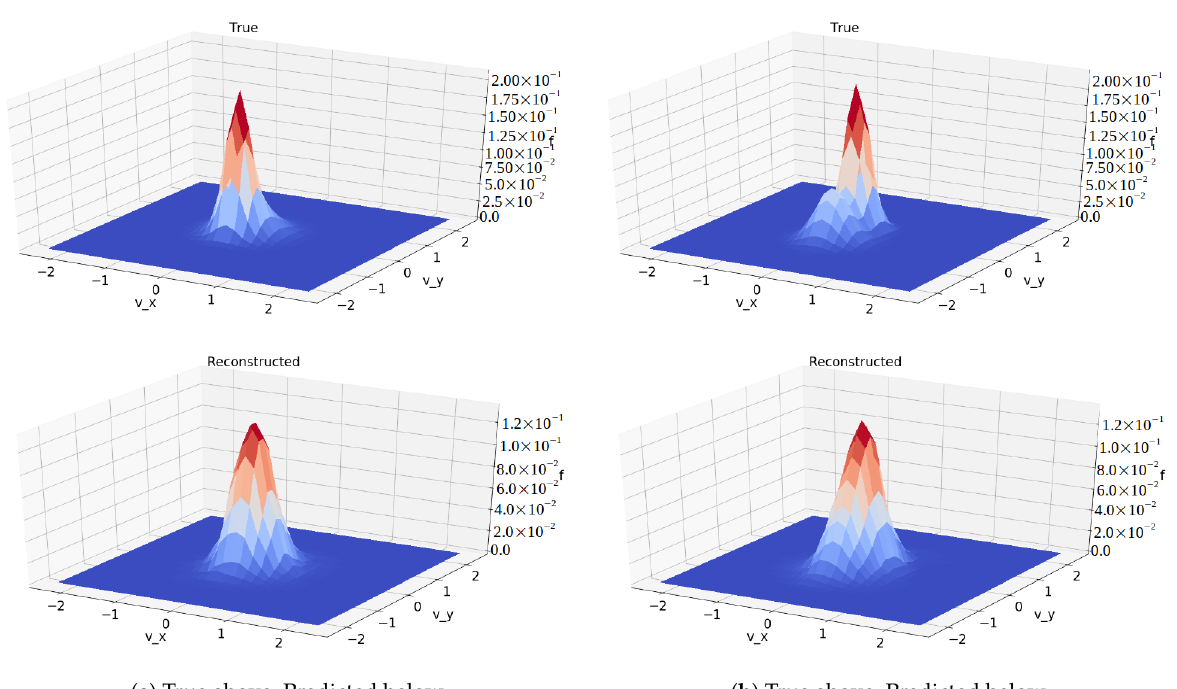
Figure 3. Comparison between true solutions ( top ) and reconstructed ( bottom ) from autoencoder with 8 × 8 × 8 × 8 bottleneck. Since the solutions are on a 3D grid, only a slice towards the center of the domain is plotted here. The reconstructions are generally good, but with sharp features having been rounded